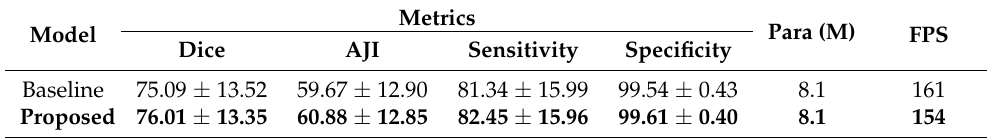
Table 1. Examining the effect of adopted attention block on segmentation result (mean ± standard deviation) incorporated with Baseline model. The best results are highlighted in